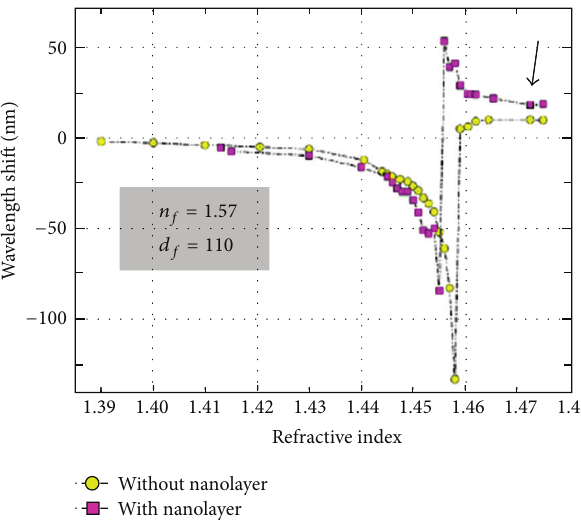
Figure 8: Thin film-coated LPFG for assessing the quality of fried oil (taken from